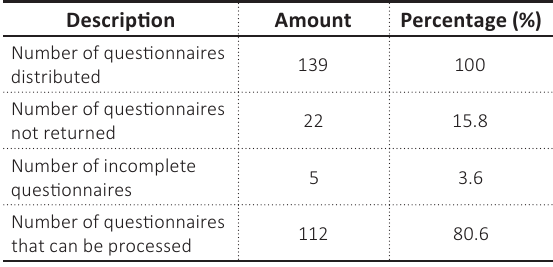
Table 1. Number of questionnaires